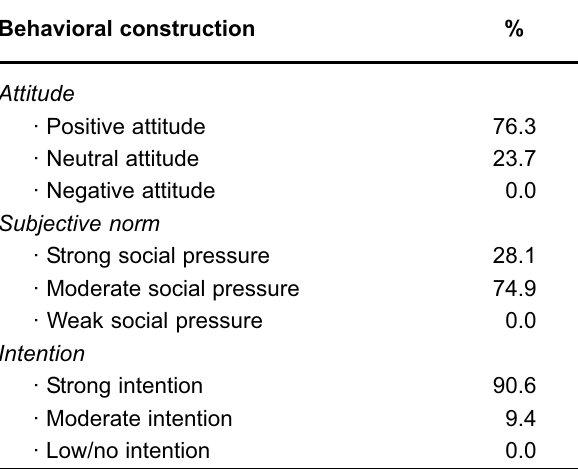
TABLE 4- Percent distribution of responses to attitude, subjective norm and intention to practice ART given by 138 Tanzanian dental